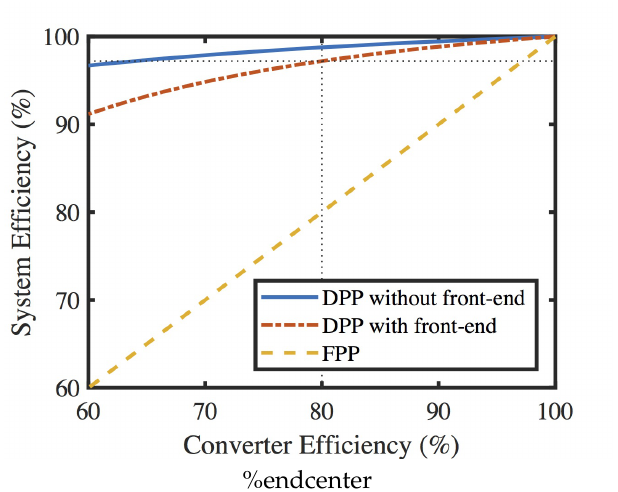
Figure 5. System efficiency at different converter efficiencies for FPP and DPP architectures.